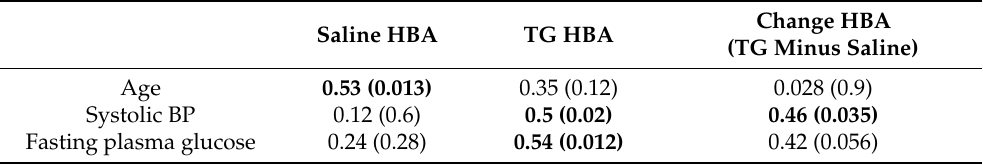
Table 3. Pearson correlation matrix, cc ( p value) with p < 0.05 bolded.